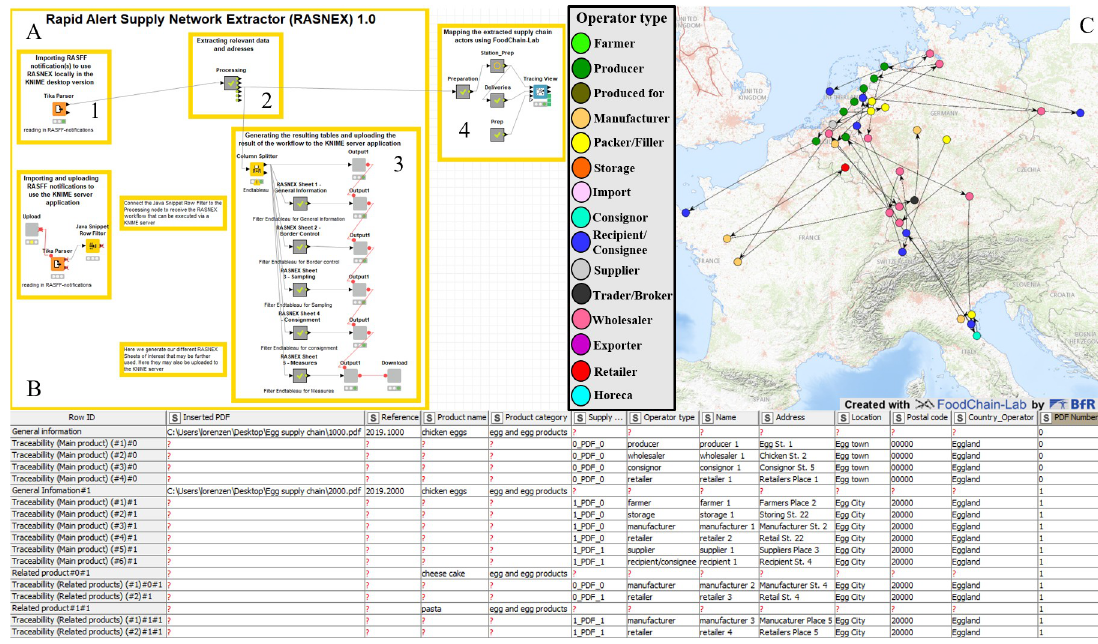
Fig 2. Function of RASNEX. (A) The RASNEX 1.0 workflow is divided into 4 parts: 1) Importing RASFF notification(s), 2) extraction, 3) mapping of operators involved in the different supply chains, 4) displaying the results on a webpage and generating the output. (B) Exemplary anonymized RASNEX 1.0 output sheet on the consignment providing information on the structure of different supply chains. (C) Graphical mapping of a chicken egg fipronil contamination incident from 2017/2018 using GIS showing 39 operators, which are part of ten different supply chains, located in seven central European countries and categorized into nine operator